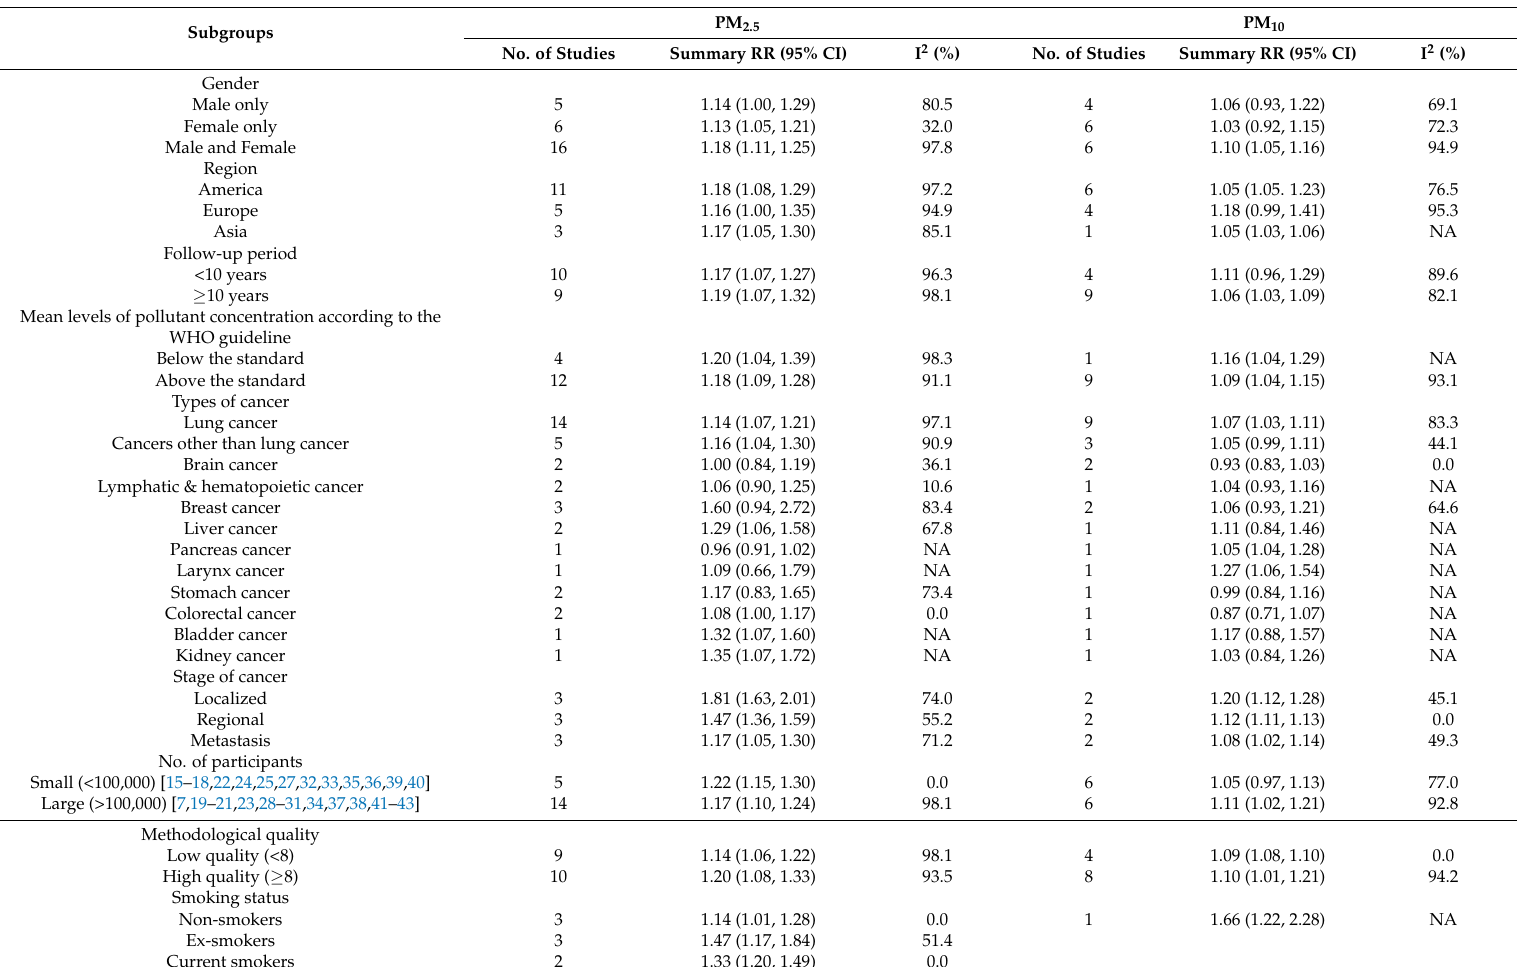
Table 2. Particulate matter and cancer mortality in the subgroup meta-analysis of cohort studies by various factors. WHO, World Health